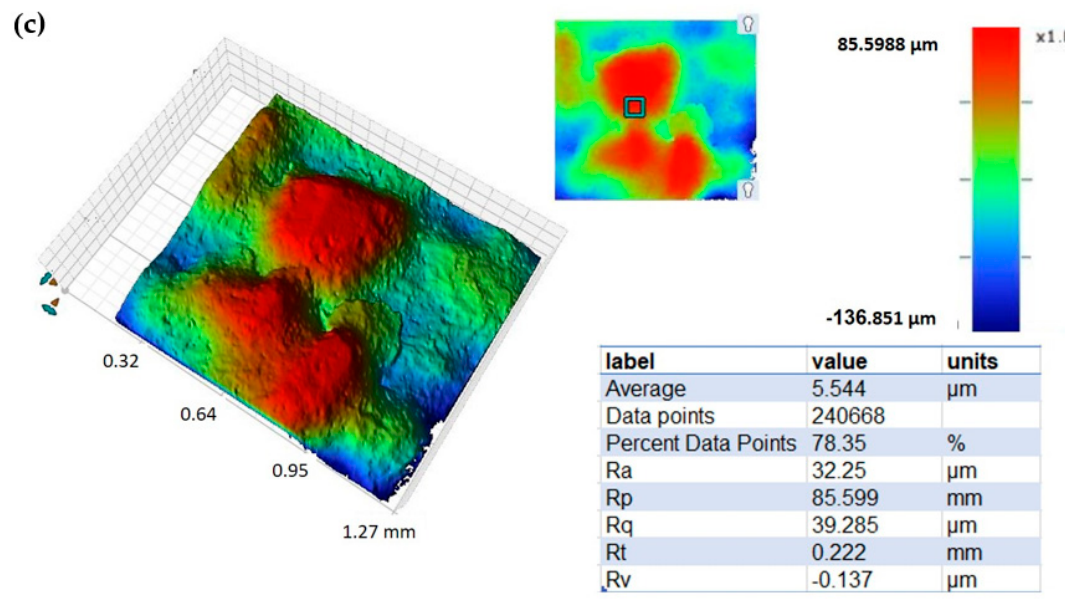
Figure 7. White light interferometry surface scans. ( a ) 17-4 PH stainless steel rod, ( b ) Ti-6Al-4V fitting, and ( c ) Al 4047 housing. Table 3. Micro-hardness, density, and surface roughness of the as-processed LENS materials. Material